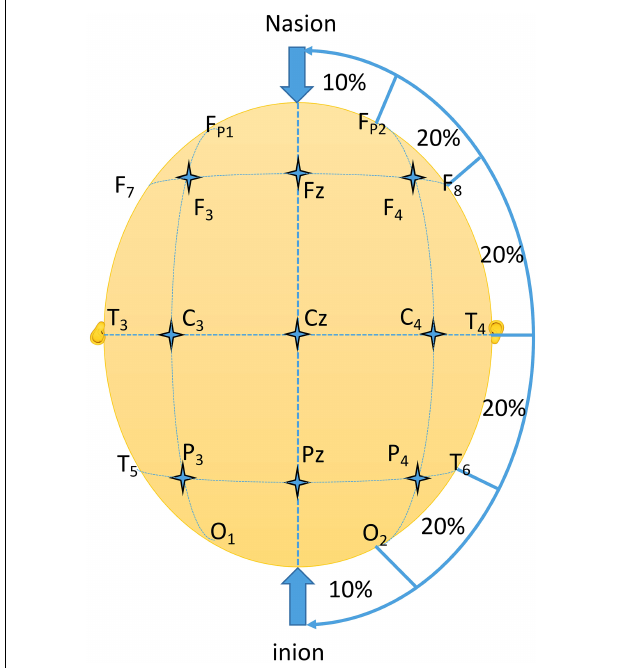
FIGURE 2 | International 10-20 EEG electrode location